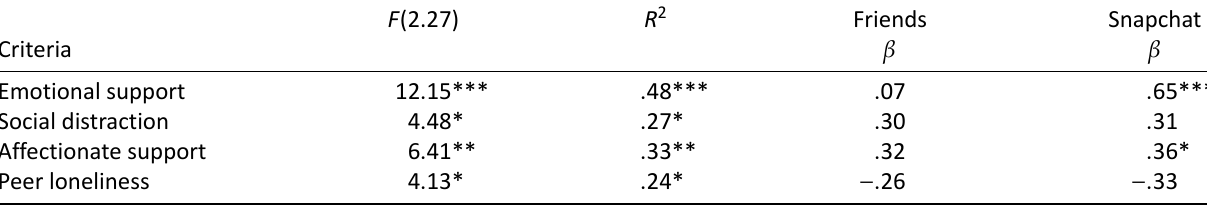
Table 2. Time spent with friends and Snapchat usage as predictors for social well-being variables for the Peer2Peer